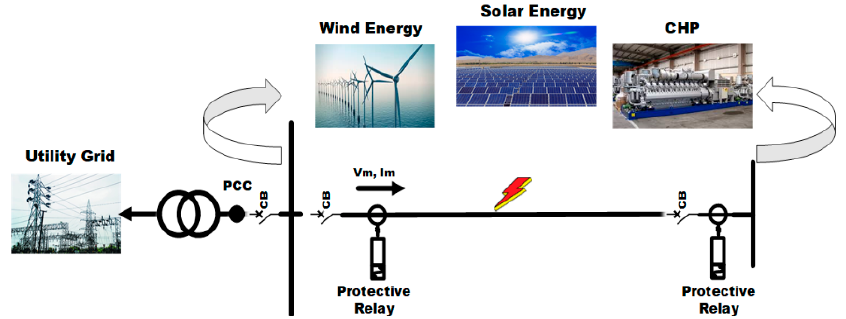
Figure 12. Impedance-based protection